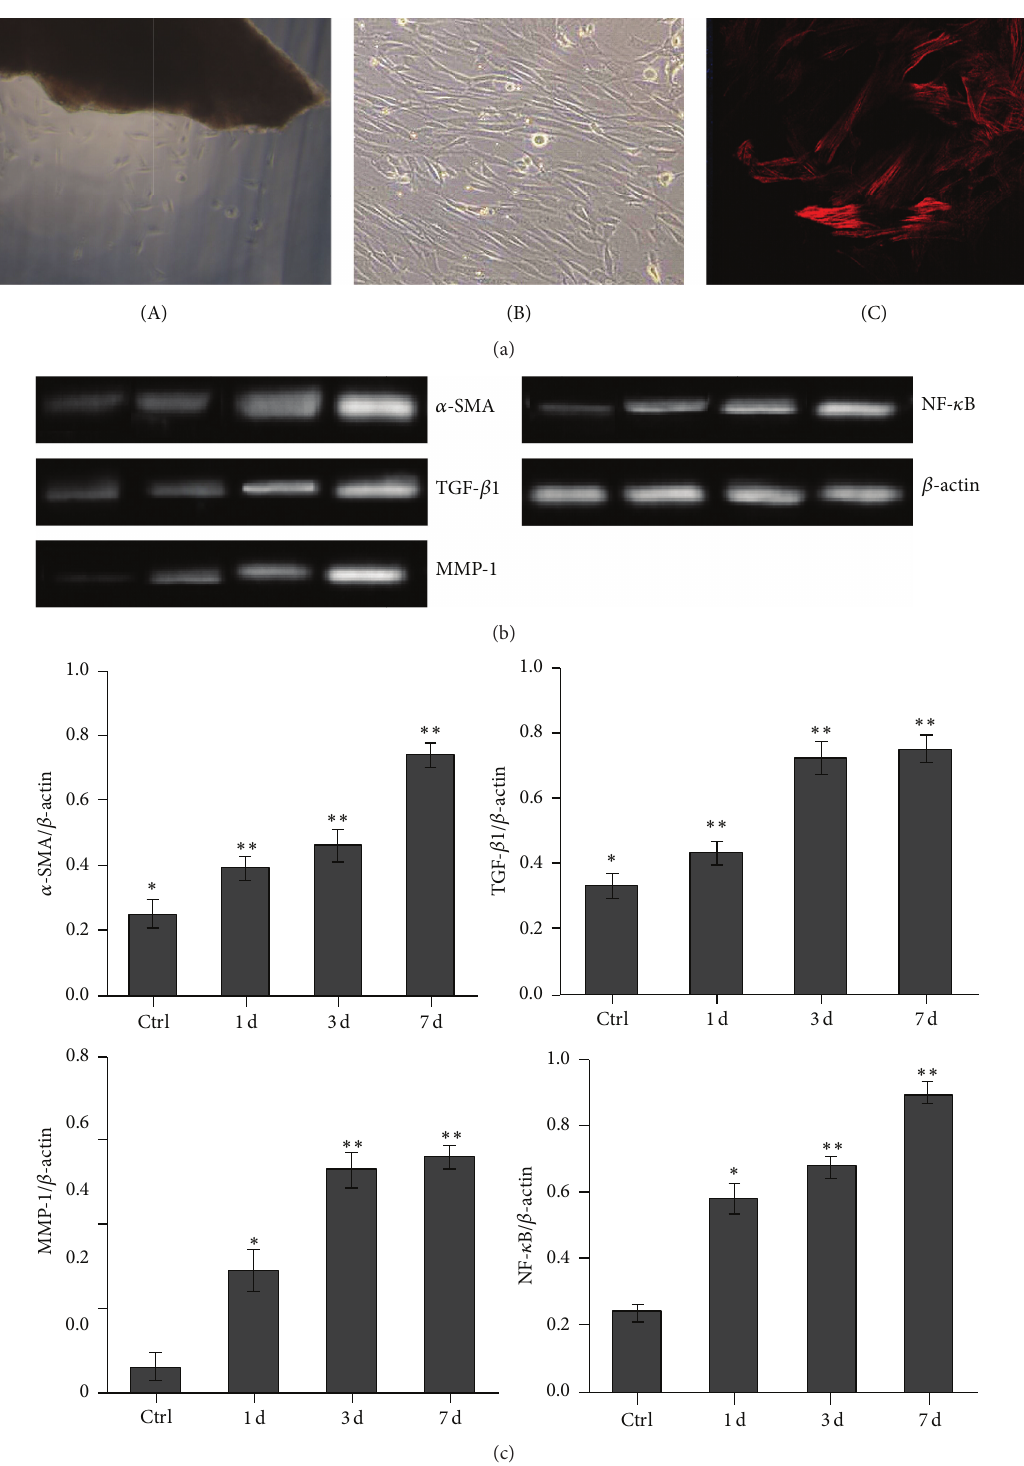
Figure 1: Characteristics of cultured vascular adventitial fibroblasts and expression of 𝛼 -SMA, TGF- 𝛽 1, MMP-1, and NF- 𝜅 B. (a) Morphological observation and representative photographs of fibroblasts. (A) Fibroblasts grown from tissue pieces of vascular adventitia ( × 100). (B) The 2-3 generations of fibroblasts showed a robust growth with a multilayer overlapping crest shape ( × 100). (C) Fibroblasts stained with Cy3 antibody (red) indicating intracellular 𝛼 -SMA after TGF- 𝛽 1 treatment ( × 400). (b) Expressions of 𝛼 -SMA, TGF- 𝛽 1, MMP-1, and NF- 𝜅 BmRNAinadventitialfibroblastsinthemodelgroupsorthecontrolgroupwithorwithoutTGF- 𝛽 1.(c)Significantdifferencesamonggroups were indicated by RT-PCR. Averages of at least three independent experiments ( 𝑛 = 3 ). Bars indicated the mean ± SD. ∗ 𝑃 < 0.05 compared to the control (model versus control, ∗ 𝑃 < 0.05 ; the model group for 3 or 7 days versus 1 day, ∗∗ 𝑃 < 0.05